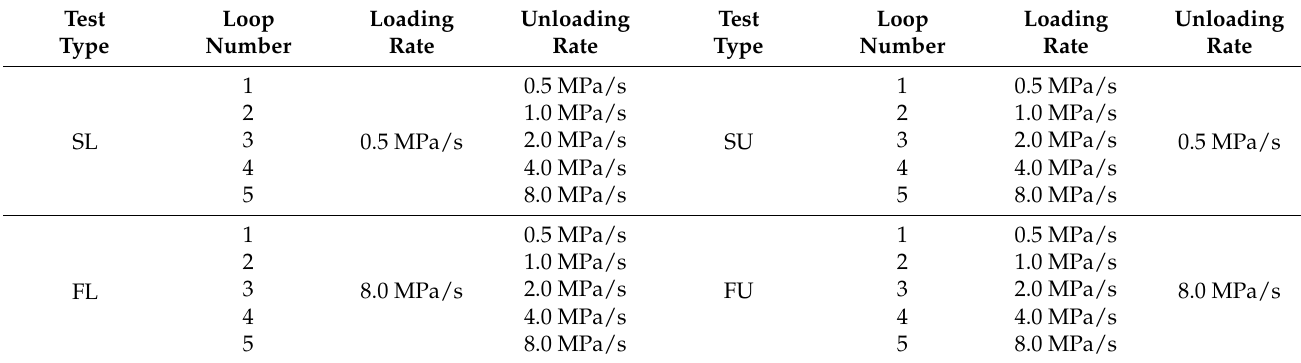
Table 1. Loading and unloading rates for cyclical experiments described under (A), (B), (C), and (D). Test Type